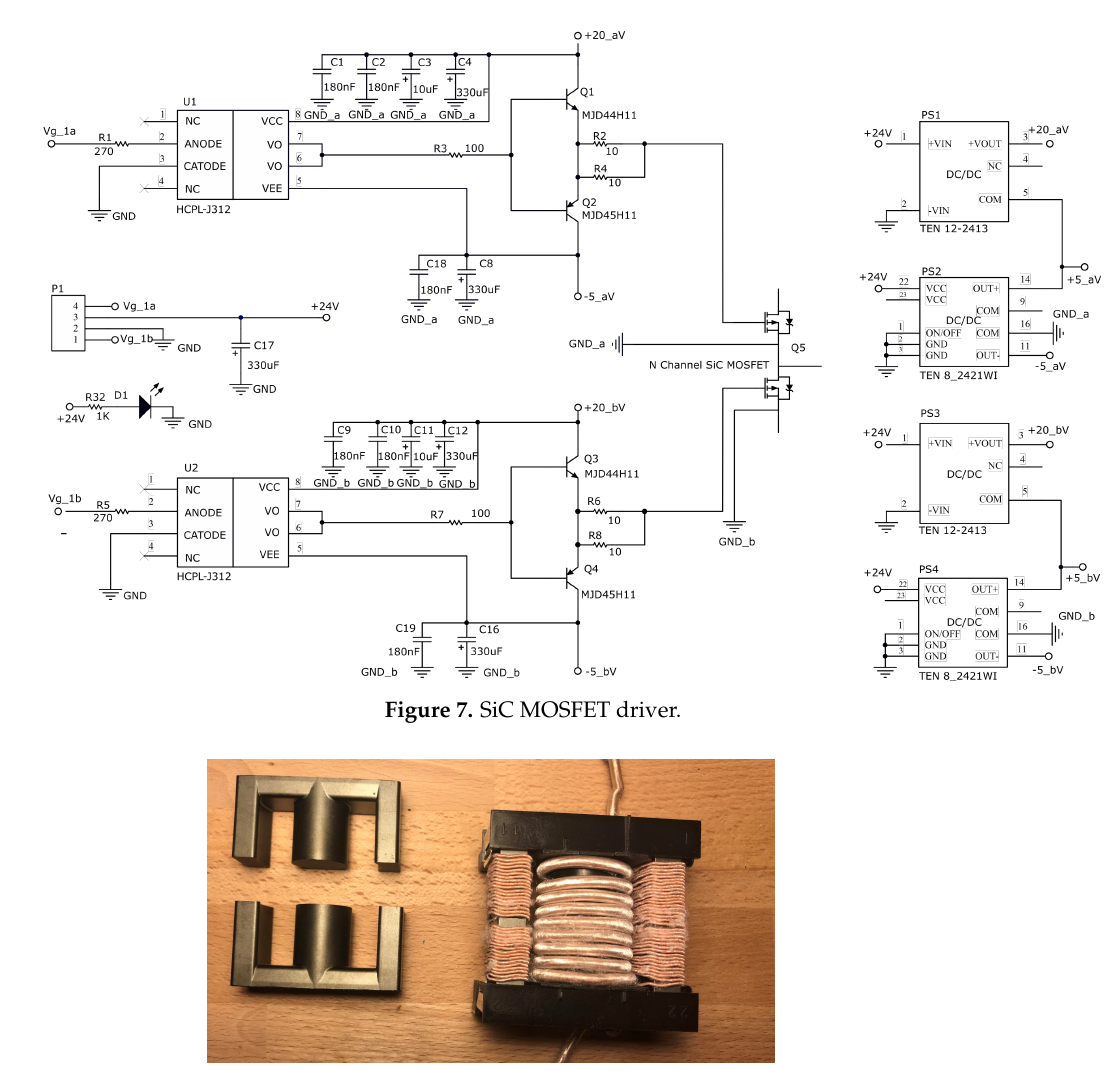
Figure 8. ETD54 core disassembled and a variable inductor.